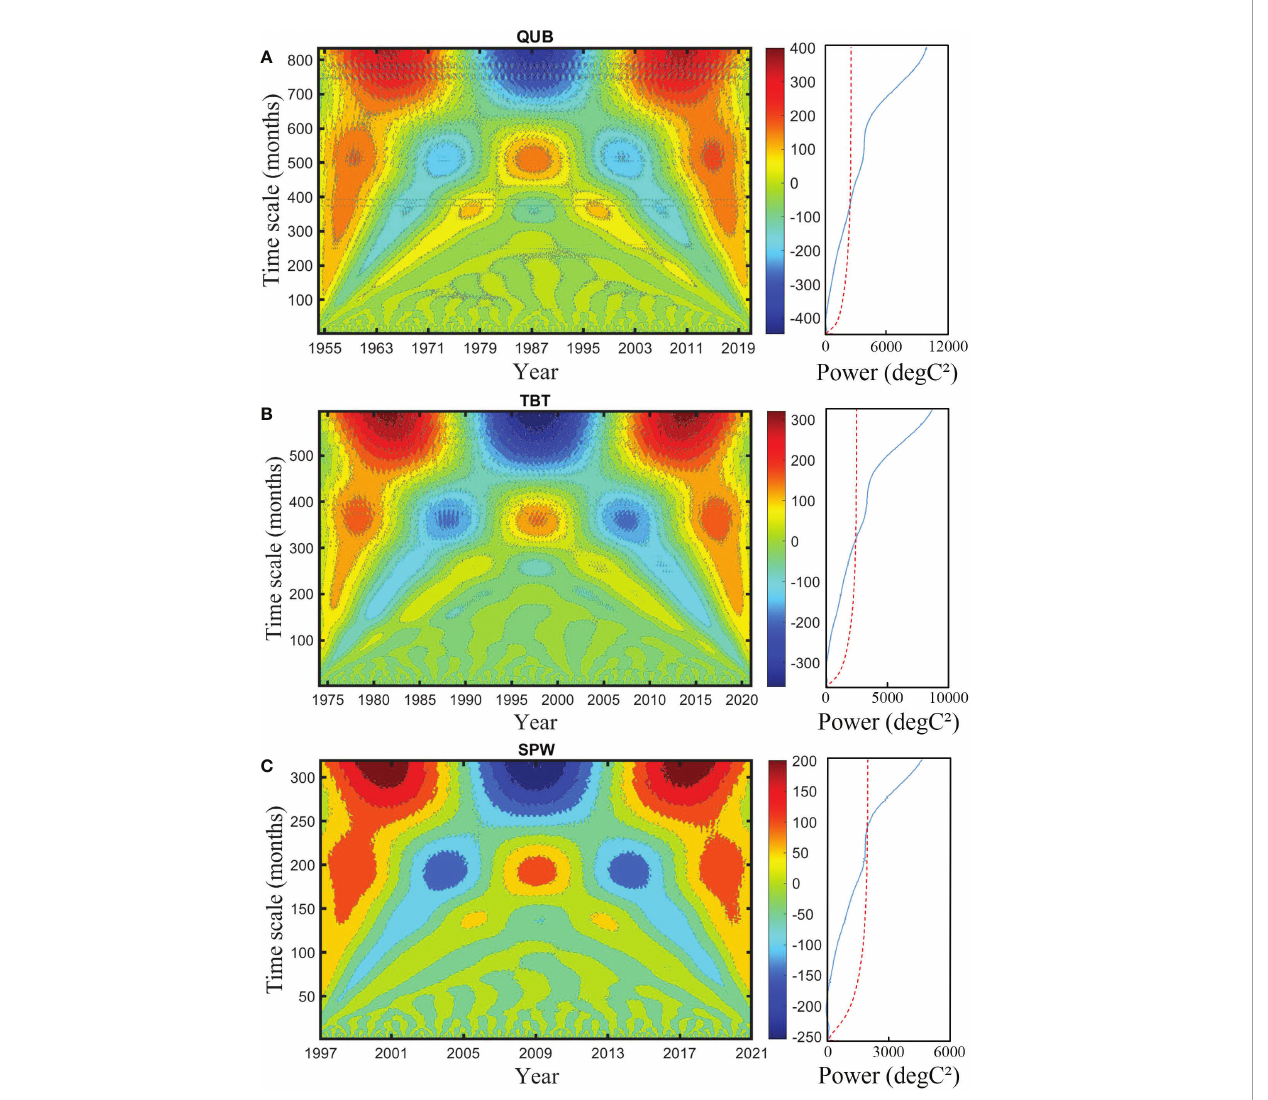
FIGURE 2 Wavelet transform (left) and global wavelet spectrum (right). (A – C) are wavelet coef fi cient contour images and global wavelet power the at the QUB, TBT, and SPW tide gauge stations, respectively. The result is signi fi cant when the global wavelet spectrum (blue line) is higher than the 95% con fi dence level (dotted red